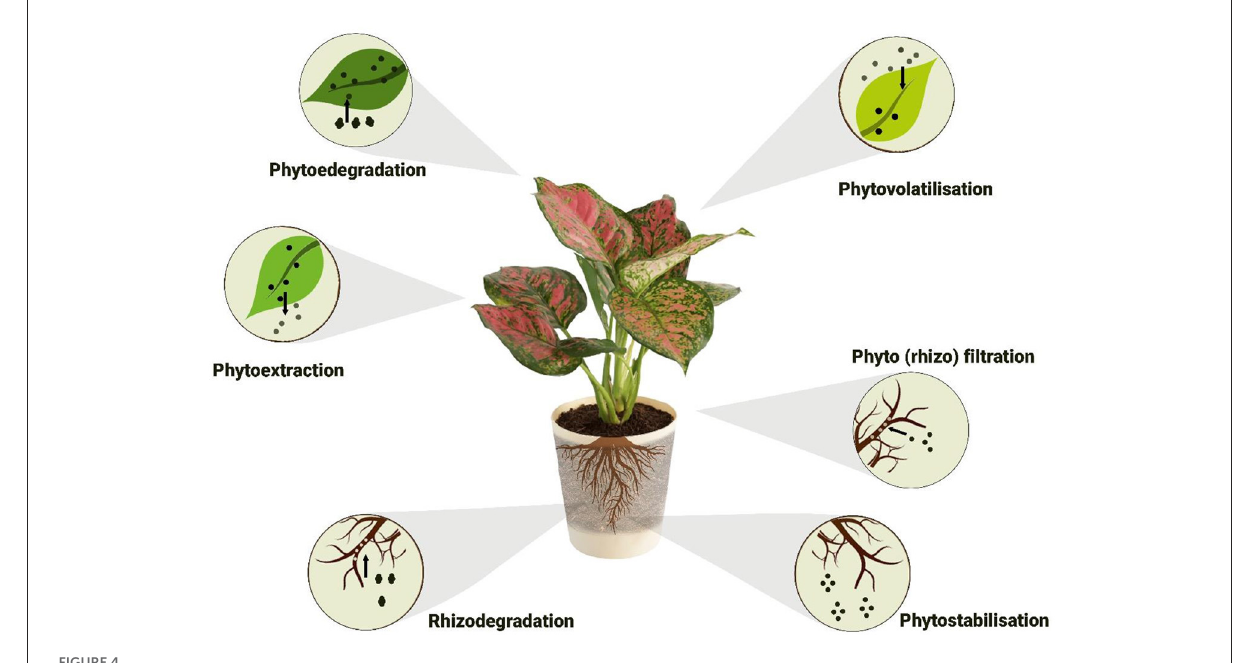
FIGURE4 Depicting different phytoremediation techniques.